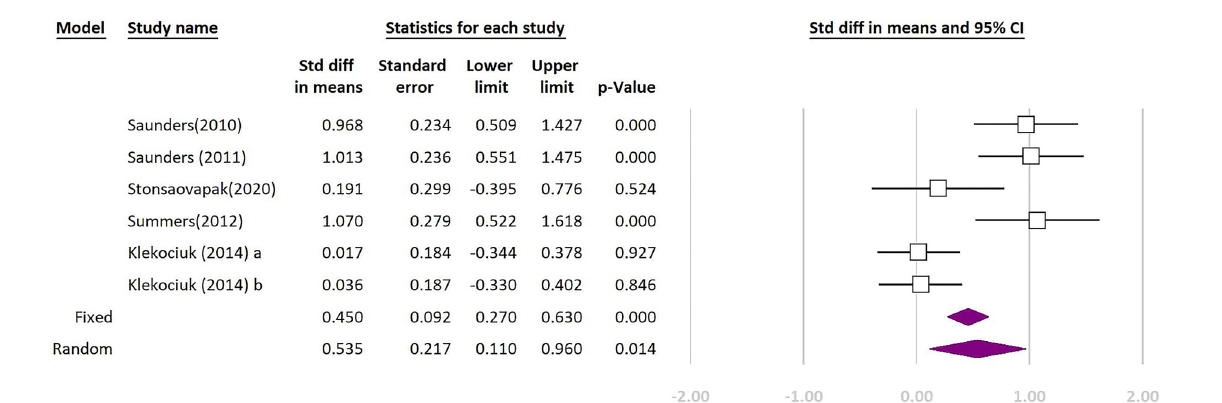
Figure 2. Meta-analysis of comparing patients with mild cognitive impairment and healthy controls based on “total errors” measure of spatial working memory (SWM) test of Cambridge Neuropsychological Test Automated Battery. The purple indicator is the final result. (Test for heterogeneity: I 2 : 81.28%; p<0.01).